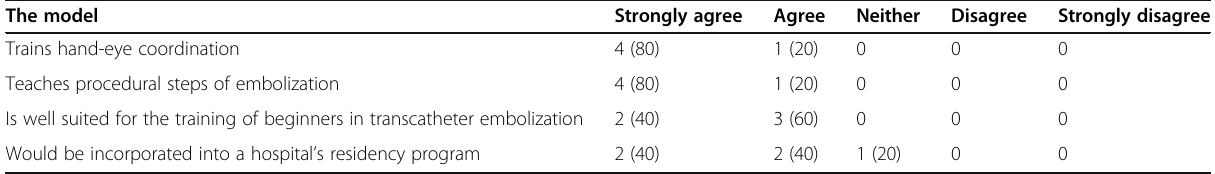
Table 3 Summarized answers of the experts to the questionnaire regarding educational validity ( n = 5) The model